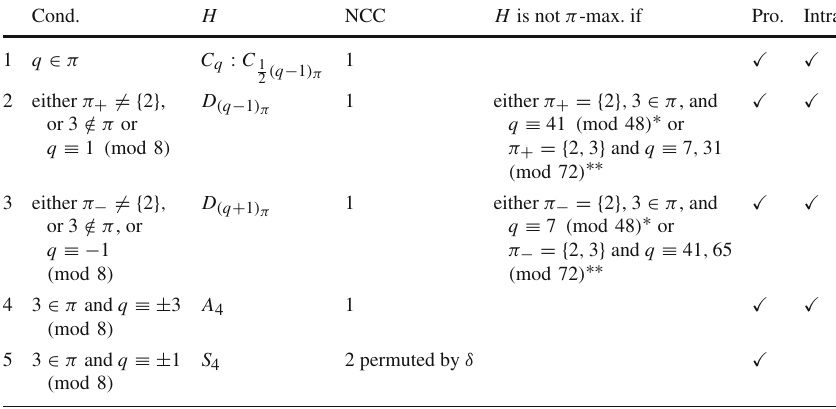
Table 6 The π -submaximal subgroups of S = L 2 ( q ) , where q > 3 is a prime, q 2 ≡ − 1 ( mod 5 ) , in the case 2 ∈ π . Notation: π ε = π ∩ π( q − ε) , ε ∈ {+ , −} , δ ∈ Aut ( S ) \ Inn ( S ) , | δ | = 2, Aut ( S ) =